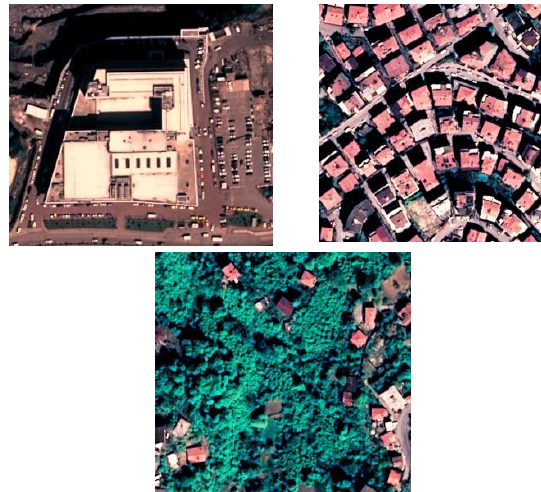
Figure 10. Sample areas generated by modified Brovey transformation.